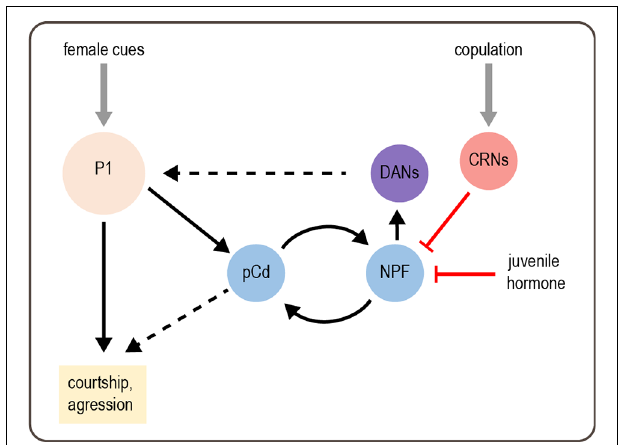
FIGURE 3 | Modulation of male behavior by sexual arousal state. Female cues activate P1 neurons, which acutely promote courtship and aggression. P1 activation also elicits a state of sexual arousal that lasts for several minutes and enhances sexual behaviors. This state is mediated by persistent activity in pCd neurons. On longer timescales, a recurrent circuit comprising pCd and NPF-expressing cells maintains a sexual arousal state. Activity in this circuit builds up over days if males do not copulate, and this activity promotes mating by enhancing P1 activity via DANs. Copulation suppresses activity in the recurrent circuit, as does juvenile hormone circulating in young males, thus suppressing mating behavior. Gray arrows depict sensory input; solid black arrows depict neural circuit connectivity; red arrows depict inhibitory modulation. Dashed black arrows represent more complex or unknown forms of modulation: DANs enhance P1 responses by desensitizing P1 to inhibition, and the targets of pCd are